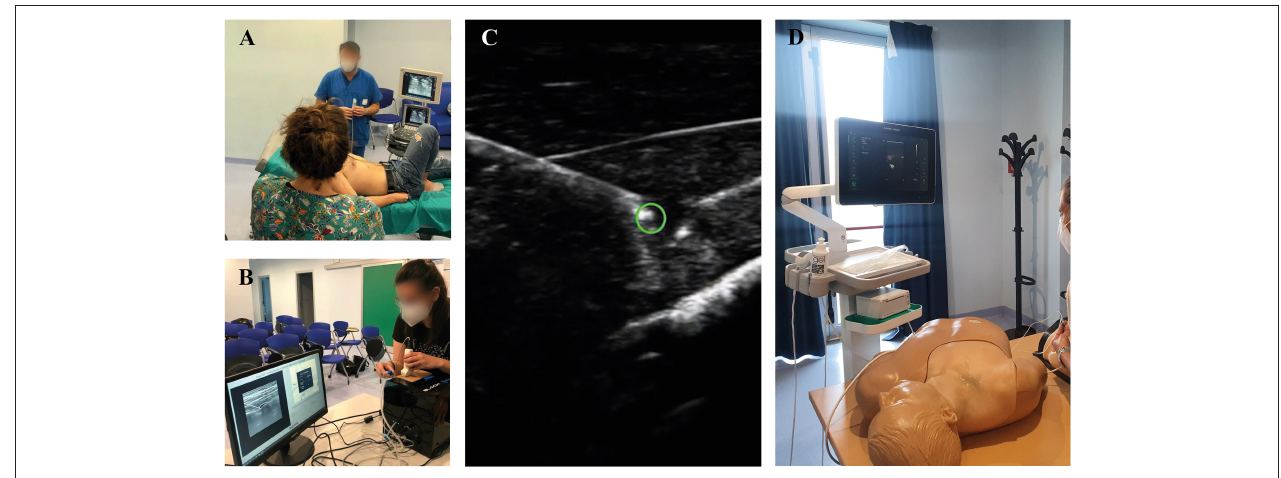
FIGURE 1 | (A) Hands-on session; (B) the BlockSim ® simulator; (C) Onvision ® Needle Tip Tracking; (D) Regional anesthesia mannequin simulation station.